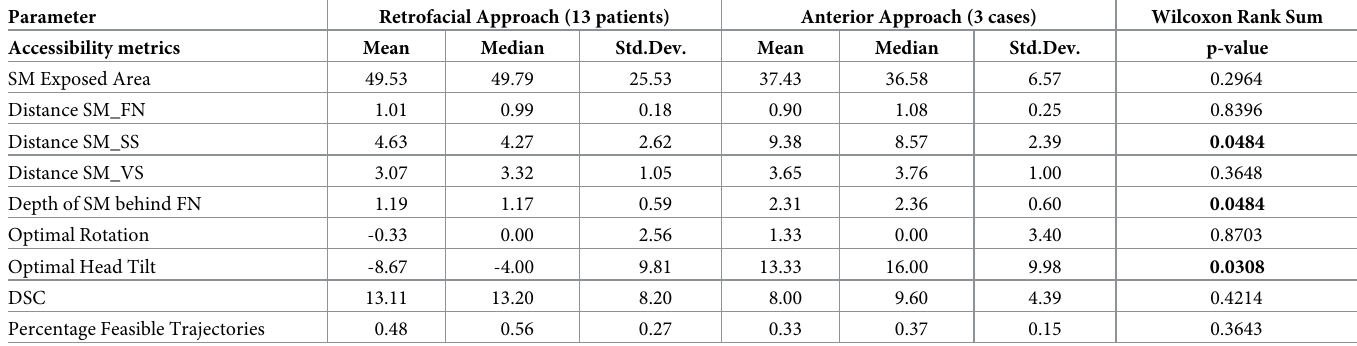
Table 3. Averaged accessibility metrics among cases accessed with the same surgical approach and statistical comparison between the two surgical approaches. Metrics are extracted from the surgical planning tool developed in [20].